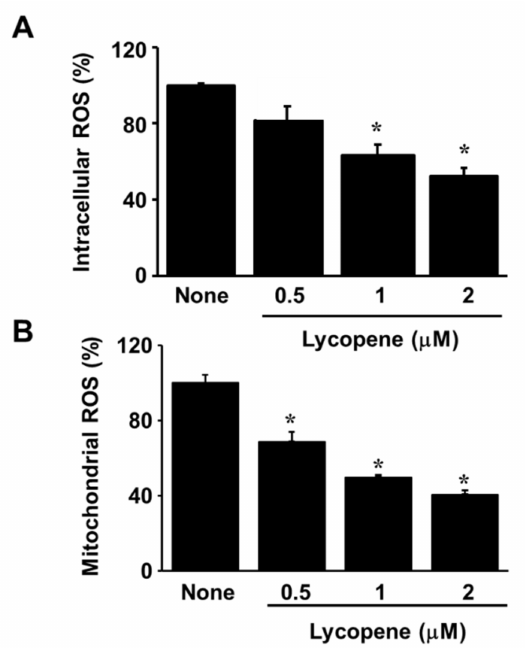
Figure 4. Lycopene reduces intracellular and mitochondrial reactive oxygen species (ROS) levels. The cells were treated with the indicated concentrations of lycopene for 1 h. The levels of intracellular ( A ) and mitochondrial ( B ) ROS were analyzed using the dichlorofluorescein and MitoSOX fluorescence, respectively. * p < 0.05 versus the cells treated with a vehicle tetrahydrofuran without lycopene